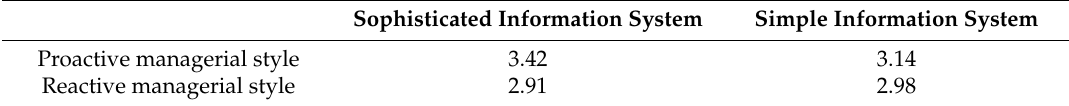
Table 4. ANOVA results: Mean scores for strategic goals towards quality enhancement (n = 122).